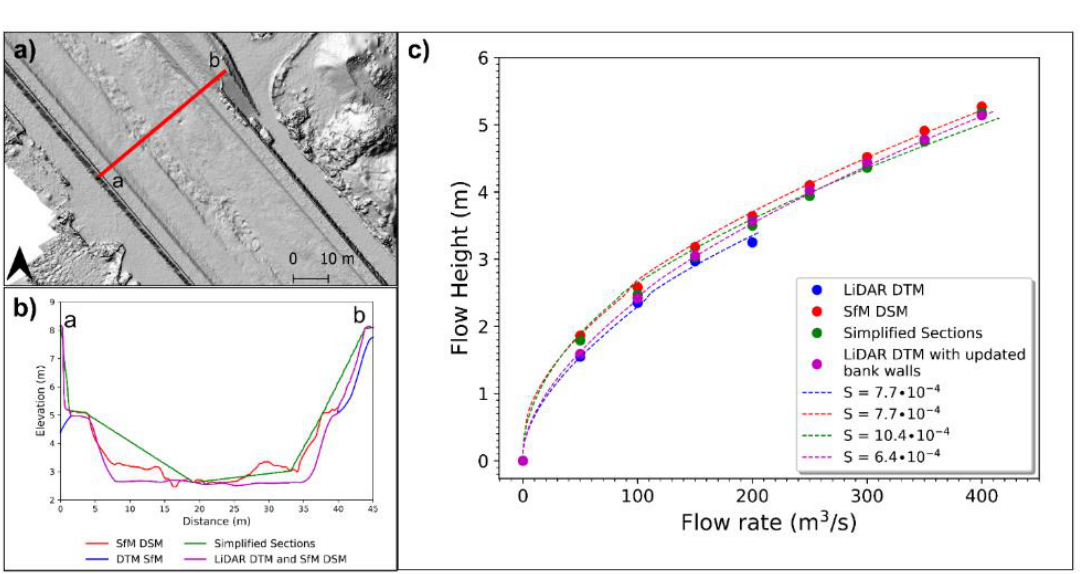
Figure 10. The relation between flow rates and flow height for different topographic data: ( a ) position of the section, ( b ) section profiles, and ( c ) flow height vs. flow rates plot where dots are calculated using FLO-2D and dashed lines are the rating curves calculated using the Manning Formula (Equation (1)).